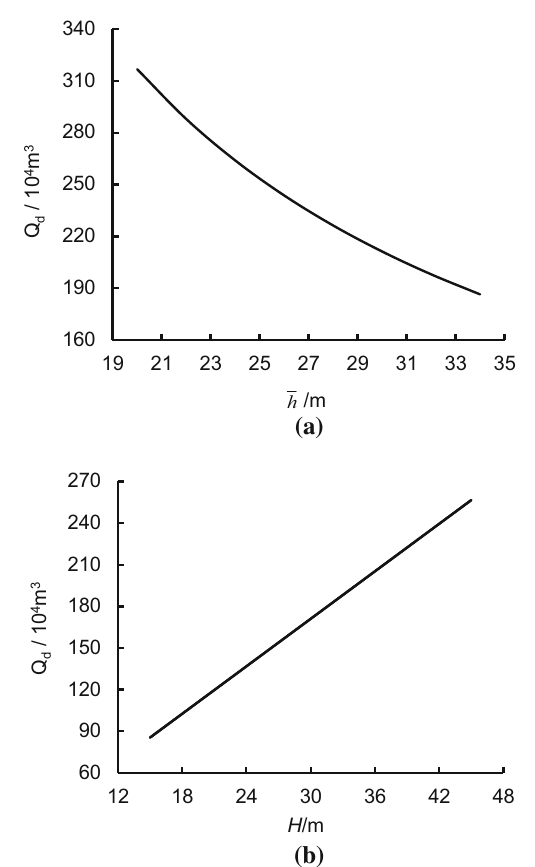
Fig. 4 Relationship between the scheduled dragline stripping volume and a the weighted average coal seam thickness and b the height of the blast casting